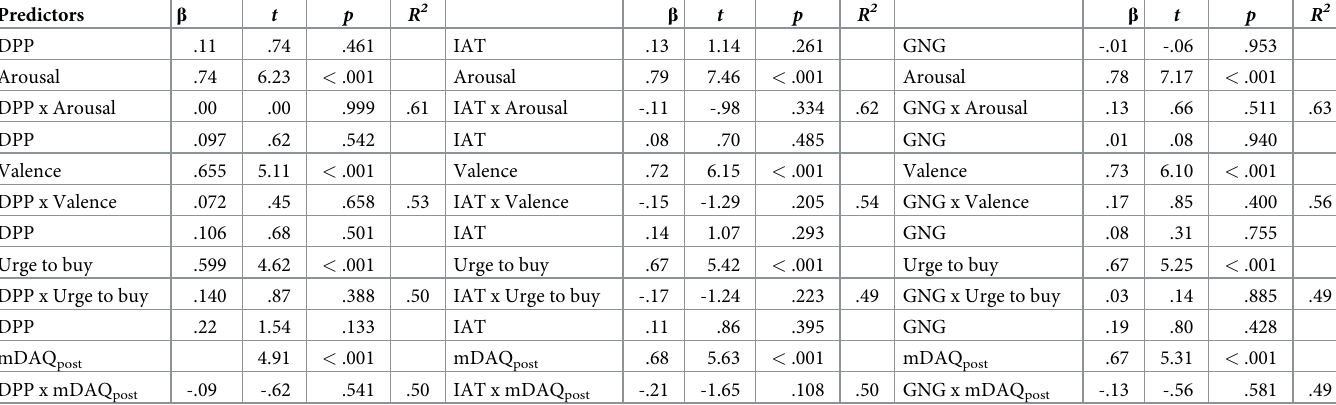
Table 4. Summary of regression analyses (step 3) investigating the impact of craving on the relationship between performance in experimental paradigms and severity of buying-shopping disorder (dependent variable: Pathological Buying Screener) in patients with buying-shopping disorder ( n = 39).